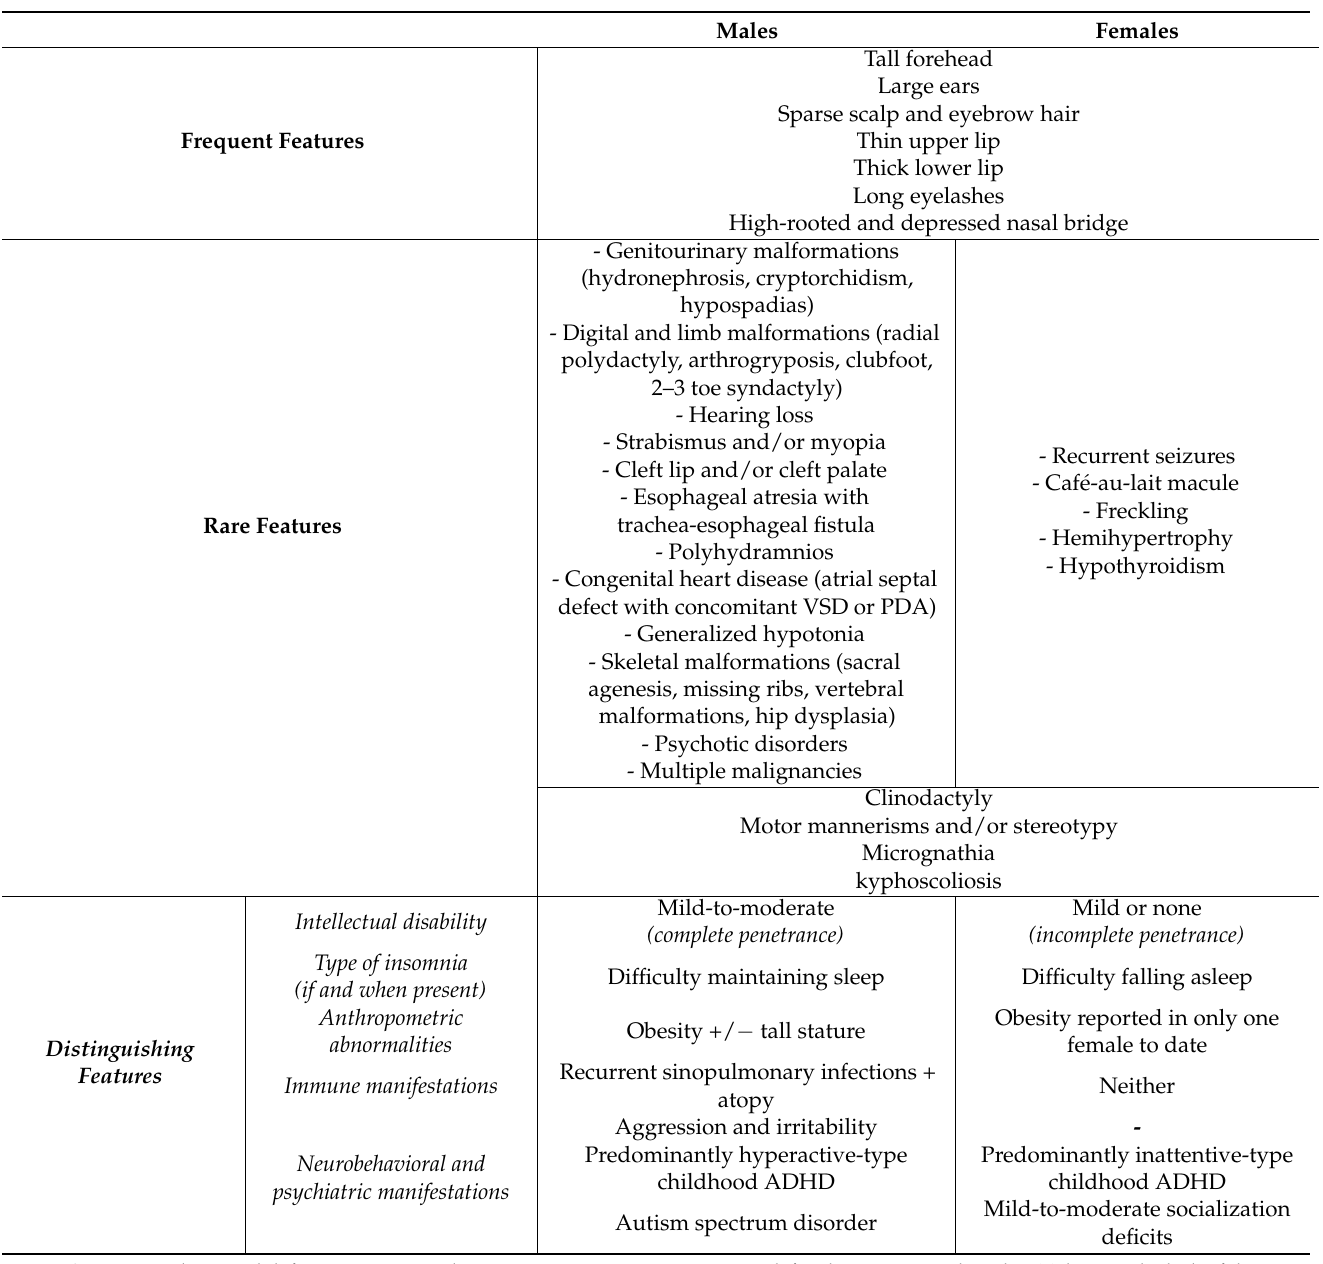
Table 1. The common and sex-specific features of int22h1/int22h2 -mediated Xq28 duplication